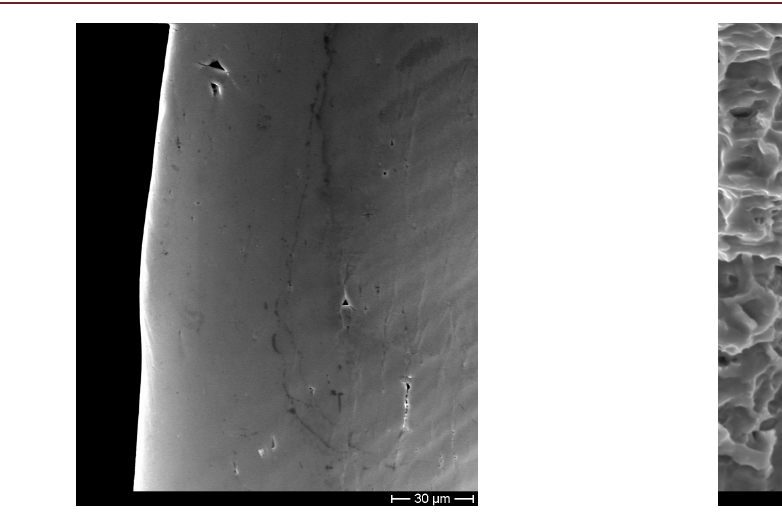
Figure 21: Micro crack on instrument no. 7 surface. Figure 22: Fracture surface of instrument number 7.